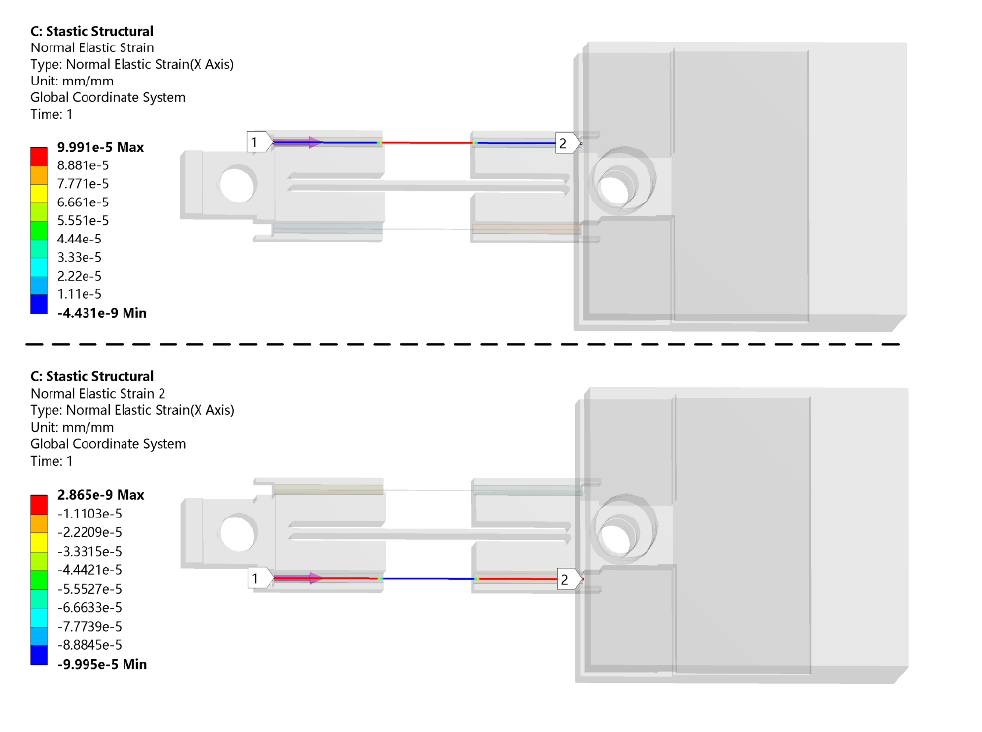
Fig. 6 Strain cloud of the tilt sensor.